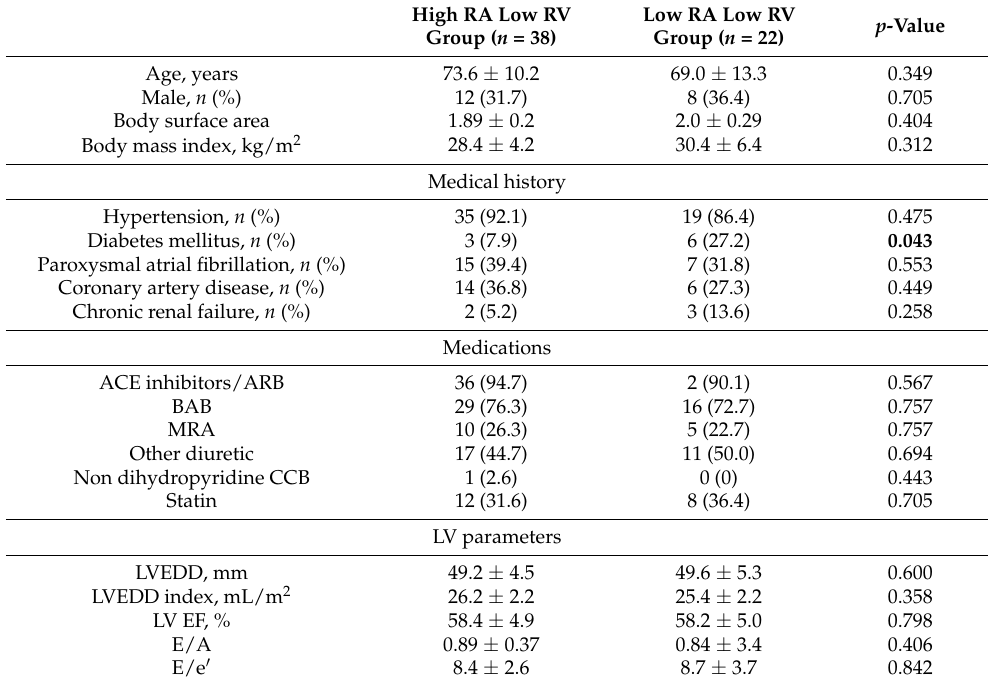
Table 2. Baseline parameters based on high and low atrial pacing, low right ventricular